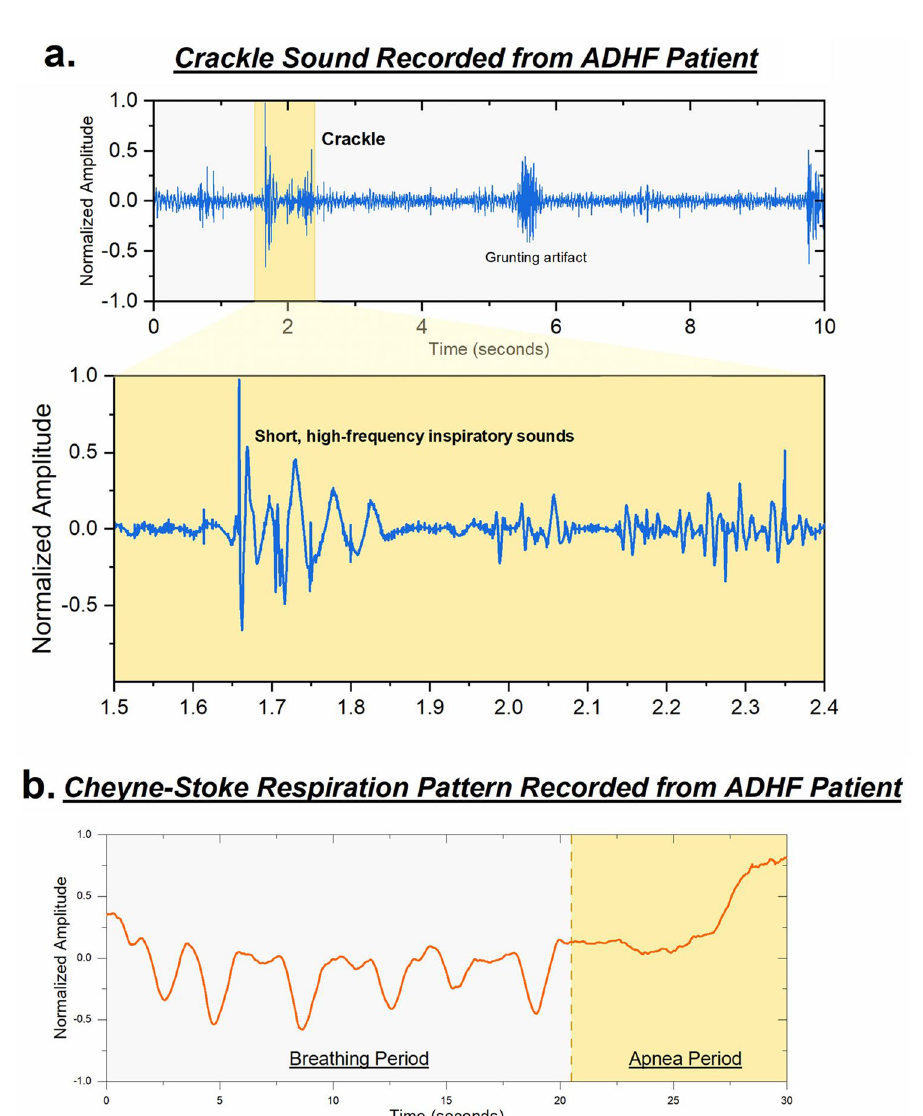
Figure 6. Pathological signals recorded from ADHF patient. ( a ) Presence of high frequency inspiratory crackle at lower lobes of the lungs indicating fluid accumulation. ( b ) Cheyne-Stokes respiration (CSR) pattern recorded from patient with ADHF and is characterized by a period of breathing followed by a period of apnea. CSR is a common indicator of heart